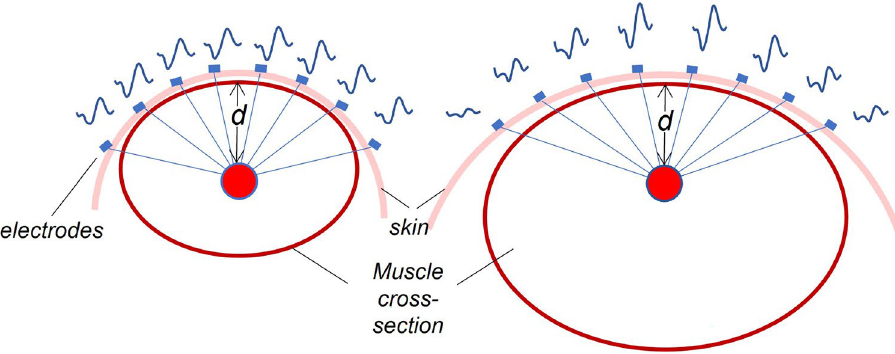
Figure 6. Effect of the muscle physiological cross-sectional area (PCSA) on the transversal MUAP amplitude distribution. Red circles represent the territories of two MUs located at the same depth (d) in two muscles with different PCSA. Right muscle (small PCSA): the distance between active fibers and the skin surface is similar for all the skin locations, leading to a uniform MUAP amplitude distribution across the detecting electrodes. Left muscle (large PCSA): the distance between active fibers and the skin surface changes for different skin locations, leading to a more localized amplitude